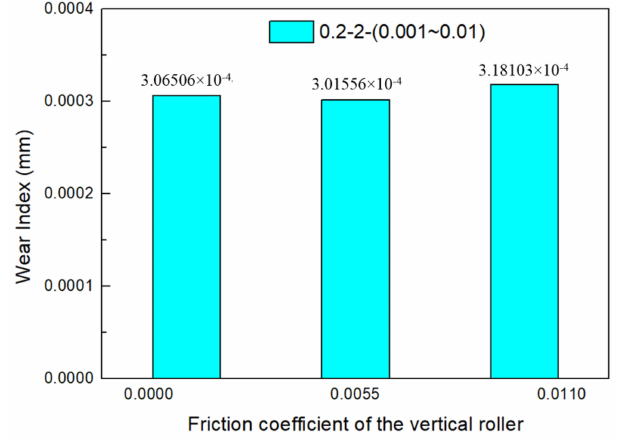
Figure 13. Influence of vertical roller friction coefficient on wear depth.